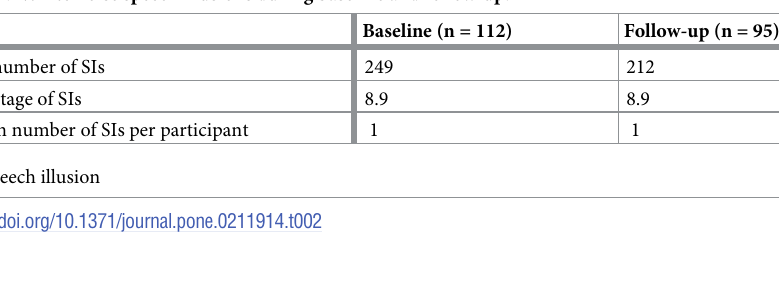
Table 2. White noise speech illusions during baseline and follow-up.